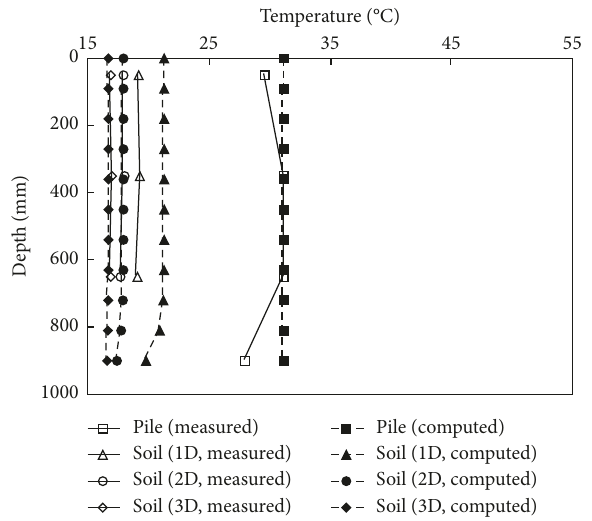
Figure 7: Thermally induced displacement at the pile head.